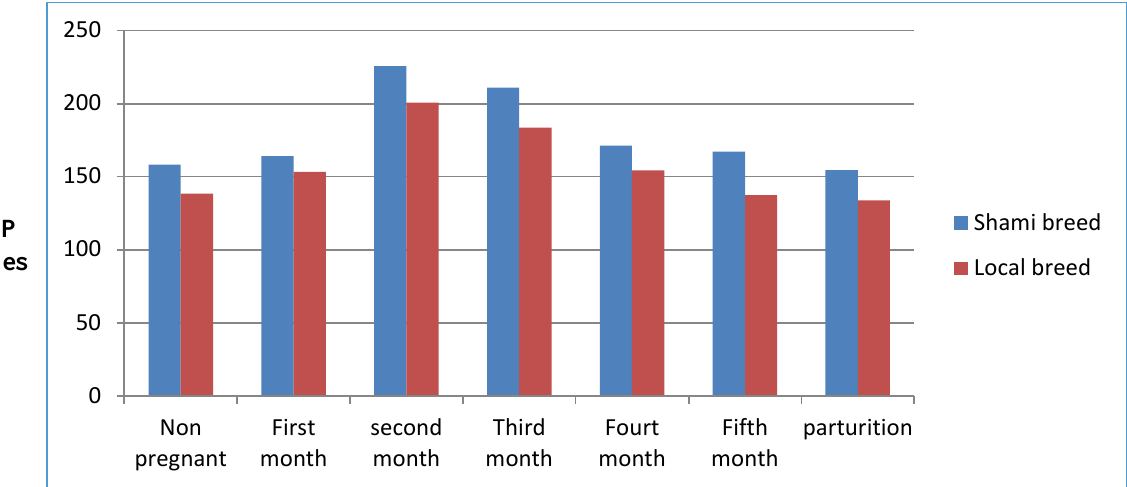
Figure, 2: ALP values during non-pregnancy, pregnancy & parturition in Shami and Iraqi